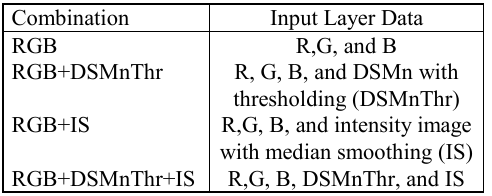
Table 1. Examples of combinations of input data layers for classification by ANN